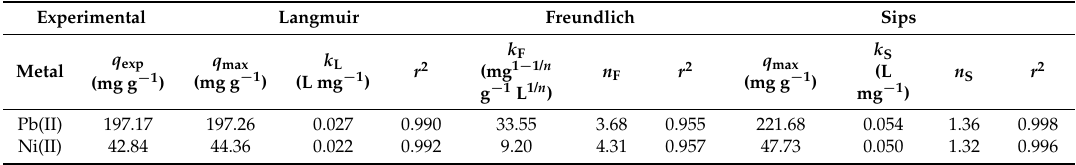
Table 2. Langmuir, Freundlich, and Sips constants of CAM-D2EHPA sorbent.